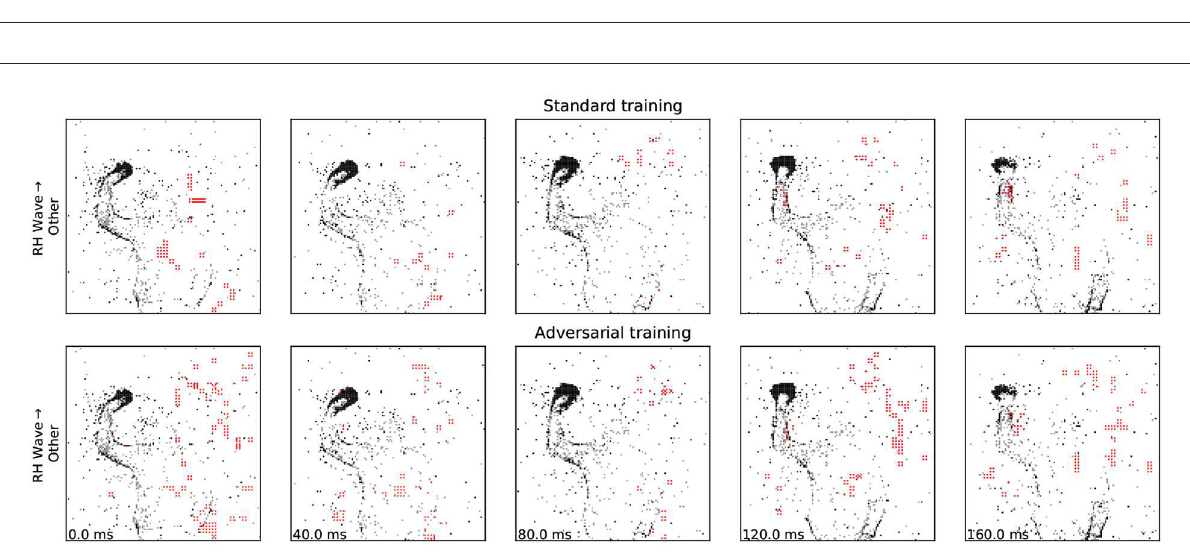
FIGURE4 Examples of adversarial patches successfully applied to a single “right hand clockwise” data sample, with different target classes. See also the Supplementary Video for motion visualization and more examples.